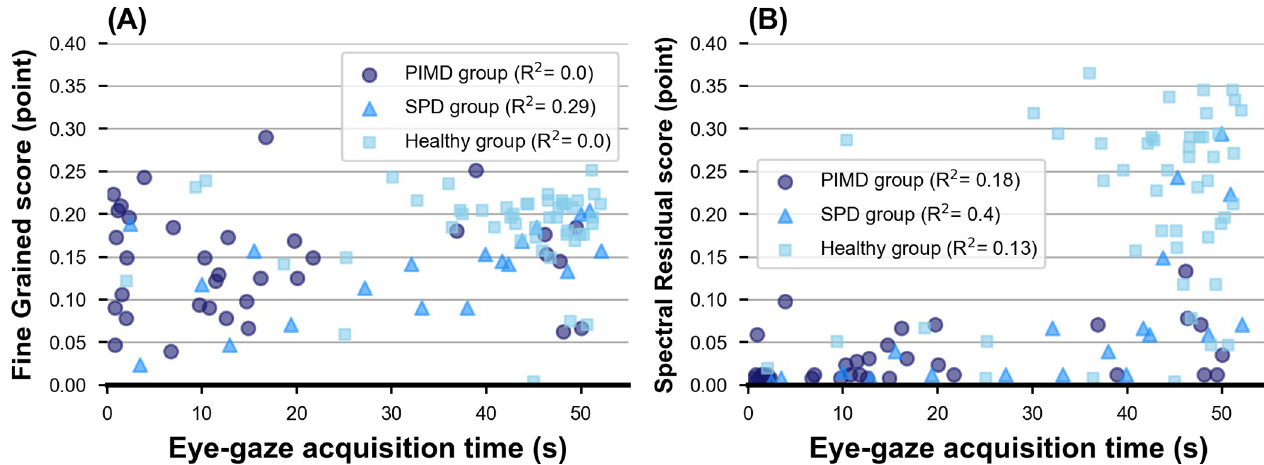
Fig 6. Relationship between eye-gaze acquisition time and saliency scores. (A) The relationship between eye-gaze acquisition time and fine-grained score. (B) The relationship between eye-gaze acquisition time and spectral-residual score. PIMD, profound intellectual and multiple disabilities; SPD, severe physical disabilities.